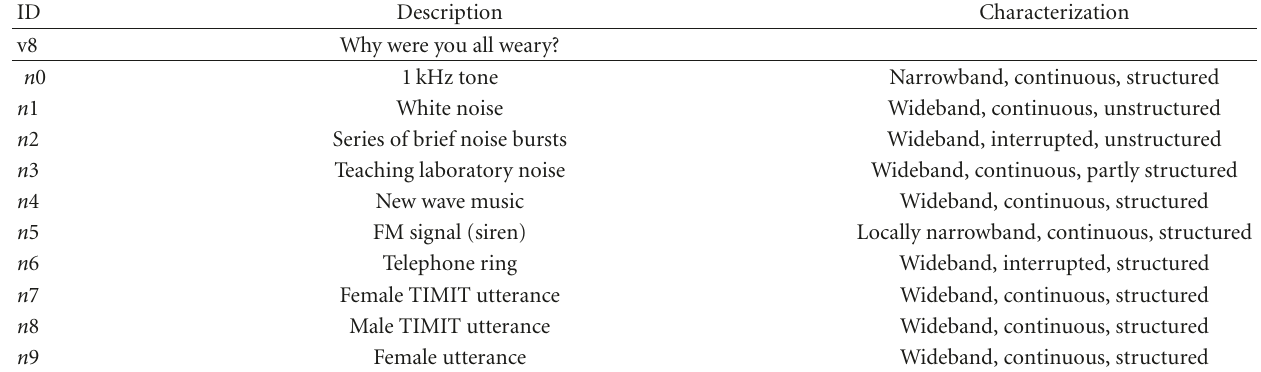
Table 2: Voiced speech signal v 8 and the interference signals ( n 0– n 9) from Cooke’s 100 mixtures [8].